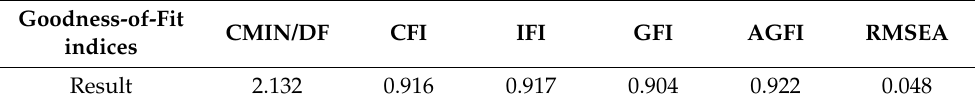
Figure 5. Partial mediating effect of negative affect experience between the rejection parenting style and the perceived non-physical bullying on school. Table 8. The model fitting goodness index table with the perceived non-physical bullying total score as the dependent variable.